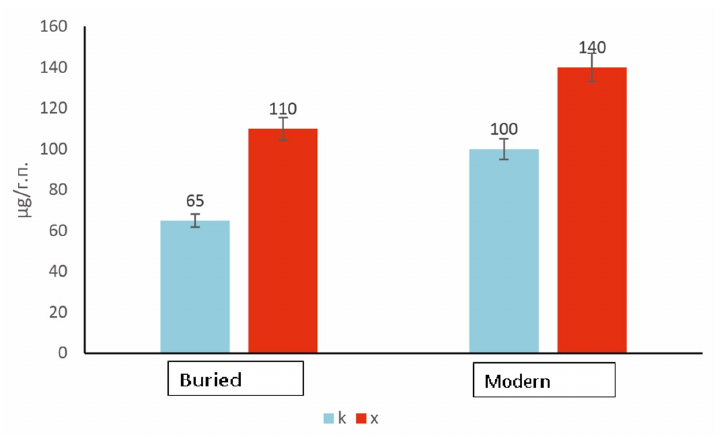
Figure 3. Total biomass of prokaryotes in the studied samples of volcanic stratified ochre soil on the 10th day of succession initiated by addition of substrate and without it: k—control; x—chitin.